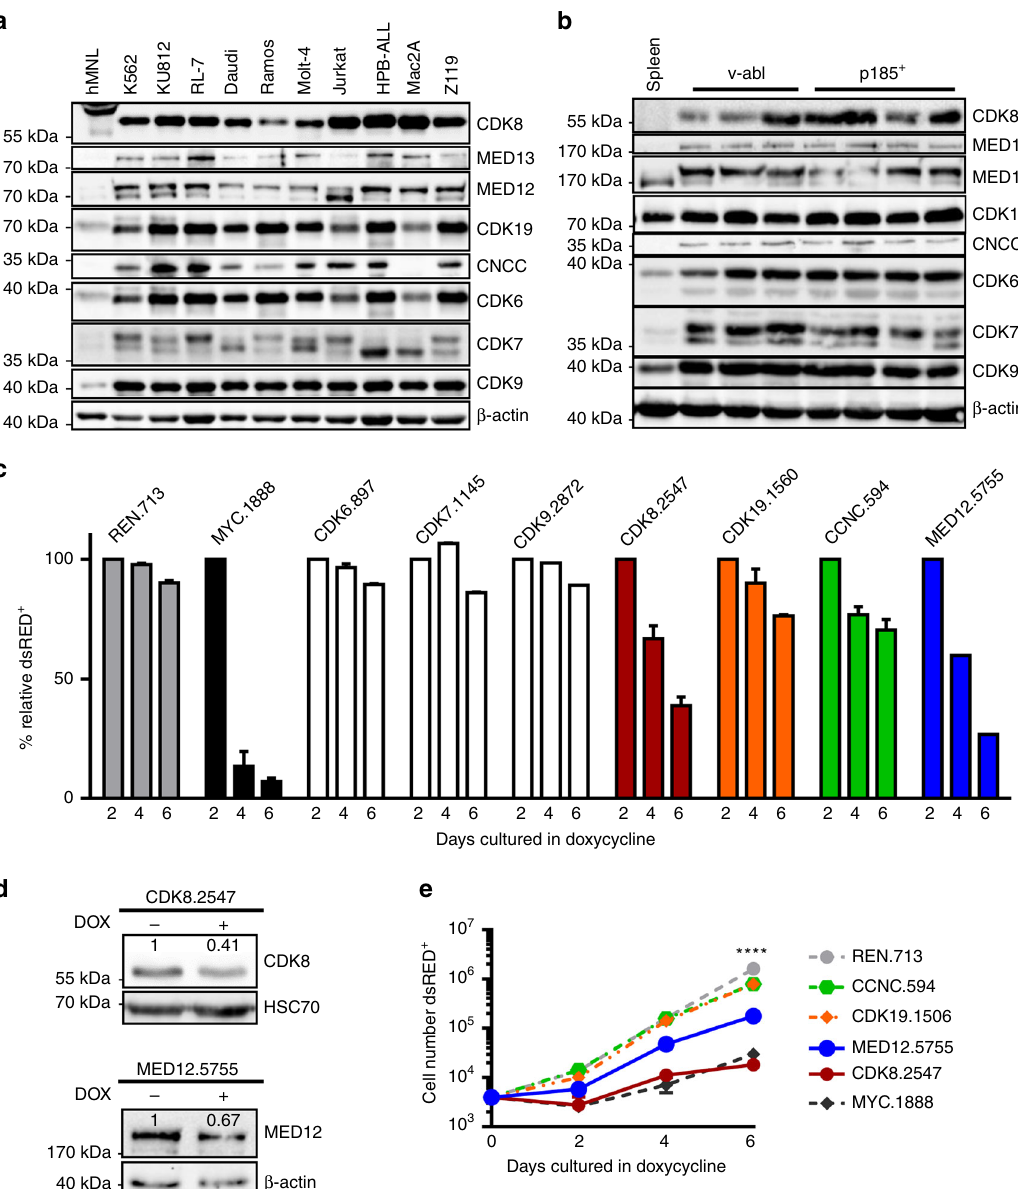
Fig. 1 CDK8 is essential for survival of BCR-ABL1 p185 + leukemic cells. Immunoblotting: levels of CDK6, CDK7, CDK8, CDK9, CDK19, CCNC, MED12, and MED13 in leukemic human ( a ) and murine ( b ) cell lines. Levels of β -actin served as loading control. c Induction of shRNA-mediated knockdowns by doxycycline. Percentages of dsRED + BCR-ABL1 p185 + leukemic cells transduced with TRE3G-dsRED-shRNA-puro (Tet-On) targeting CDK6, CDK7, CDK8, CDK9, CDK19, CNCC, or MED12. Numbers indicate the starting point of shRNA sequence. Data represent frequencies of dsRed + BCR-ABL1 p185 + cells over time, normalized to the percentages of dsRED + cells after 2 days of doxycycline (DOX) administration. shRNAs directed against Renilla (REN) or MYC served as negative and positive controls. One representative experiment performed in duplicates out of three with similar outcome is shown. d Veri fi cation of shRNA-mediated knockdown of CDK8 and MED12 by immunoblotting (day 2 after doxycycline administration). β -Actin and HSC70 served as a loading control. Numbers refer to densitometric analysis of the blotted protein in reference to loading control levels. e Growth curves of shRNA-expressing (dsRed + ) Tet-On BCR-ABL1 p185 + cells. One representative experiment performed in triplicates out of three with similar outcome is shown. Levels of signi fi cance were calculated using two-way ANOVA followed by Dunn ’ s test; data represents means ± SD (**** p < 0.0001). Source data are provided as a Source Data fi le